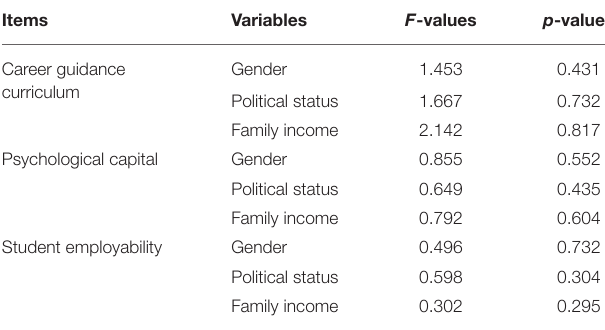
TABLE 2 | Reliability analysis results of the questionnaire survey (QS).